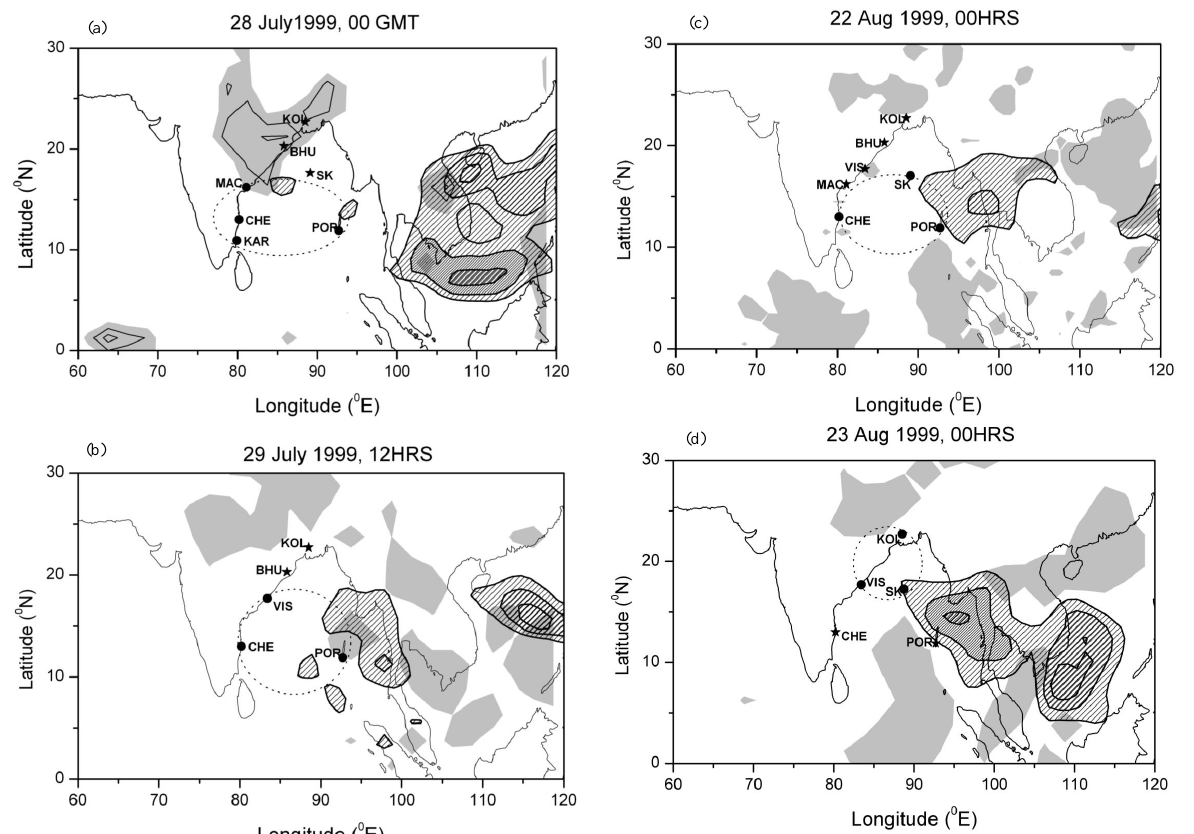
Fig. 5. Figure shows plots of locations of Radosonde/GPS Sonde stations with T CPT ≤ 191K which are marked with filled circles. These points are joined with a smooth curve drawn with dashed lines. Radiososonde/GPS Sonde stations with T CPT > 191K are shown by Stars for distinction. Contour maps of low OLR (i.e. ≤ 160Wm − 2 , and that of low T 100 (i.e. T 100 ≤ 191K) from ECMWF reanalysis temperature data are shown. Areas of low OLR are shaded with grey and areas of low T 100 temperature are hatched. (a) 28 July 1999, 00:00GMT, (b) 29 July 1999, 12:00GMT, (c) 22 August 1999, 00:00GMT, (d) 23 August 1999, 00:00GMT, (e) 24 August 1999, 00:00GMT, (f) 25 August 1999, 18:00GMT, (g) 26 August 1999, 12:00GMT, (h) 26 August 1999, 18:00GMT and (i) 27 August 1999,